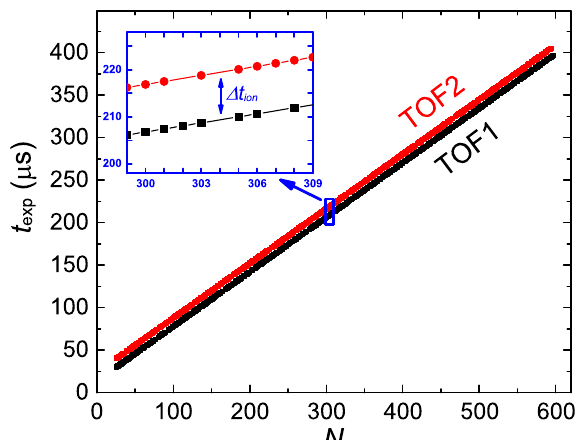
FIG. 2. Time sequences of a single 45 V 23 þ ion measured by TOF1 and TOF2 detectors as a function of the revolution number N . For illustration purpose, the time stamps from TOF2 are shifted upwards by 10 μ s. The inset illustrates a region zoomed at 299 ≤ N ≤ 309 showing the missing time stamps in some revolutions. The error bar of each data point is within the symbol size.